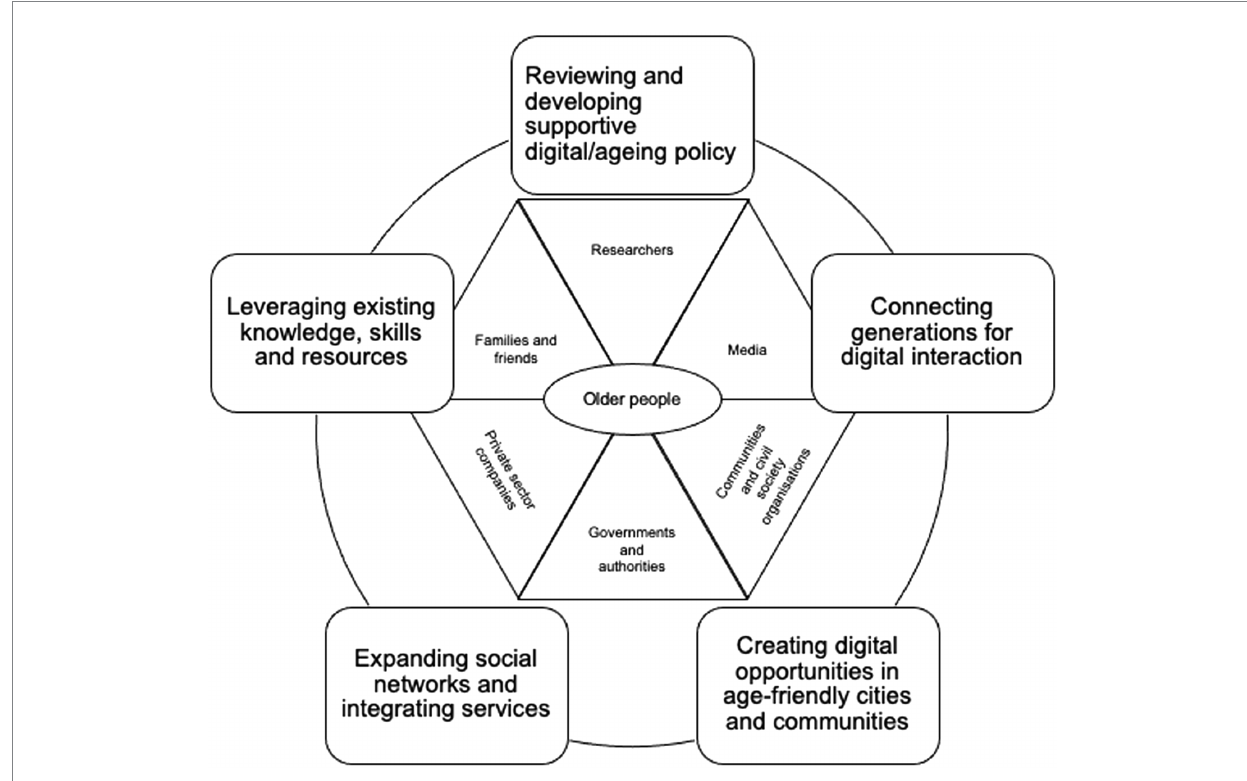
FIGURE 1 A visual guide to partnership building for digital participation in later